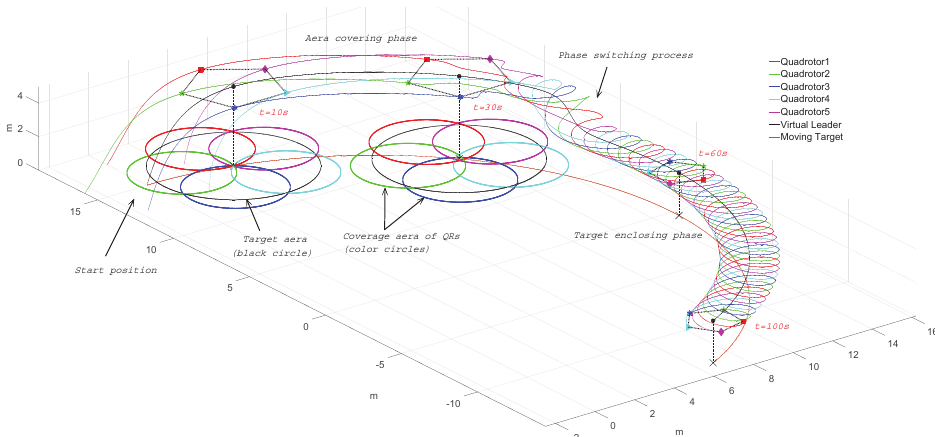
Figure 5. Trajectory, position snapshots and coverage areas of Quadrotors (QRs) and a moving target with T 1 = 35 s , T 2 = 40 s , T 3 = 45 s